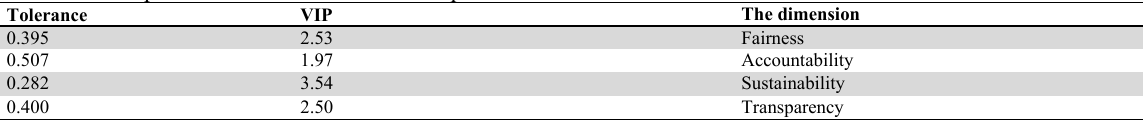
Results of multiple correlation test between independent variables Tolerance